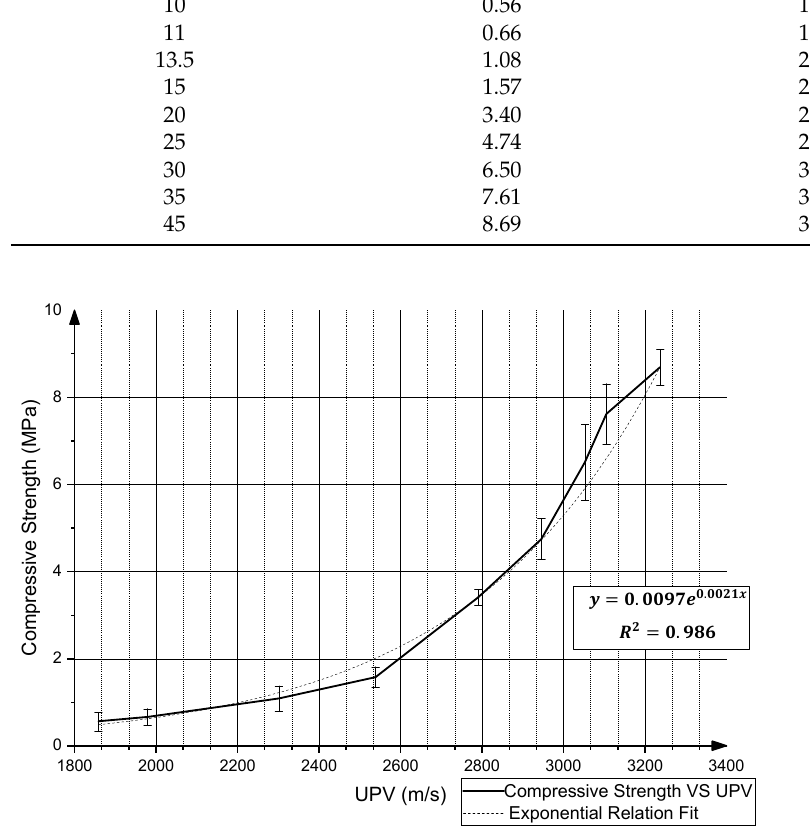
Figure 13. Plot of early-age compressive strength VS UPV for mix 2.